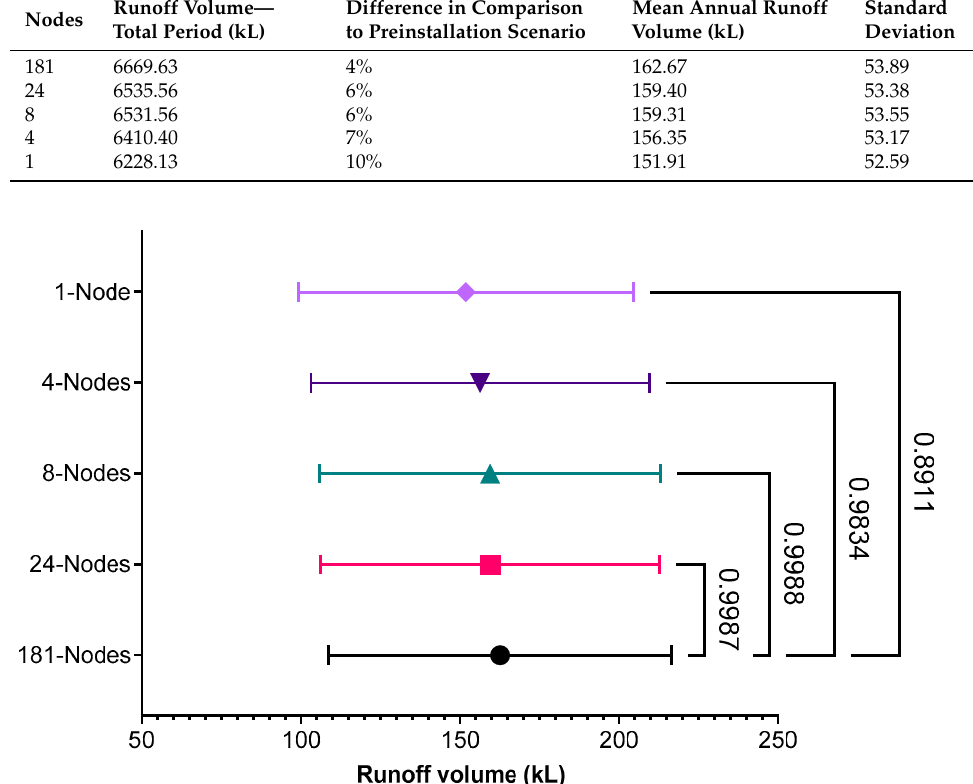
Figure 9. The effect of aggregation on the ability of the MUSIC tool to predict runoff volume from the case study catchment with 181 curbside leaky wells. The figure also shows p -values of post hoc Tukey’s multi comparison test with reference to detailed model with 181 nodes to mentioned aggregation levels.